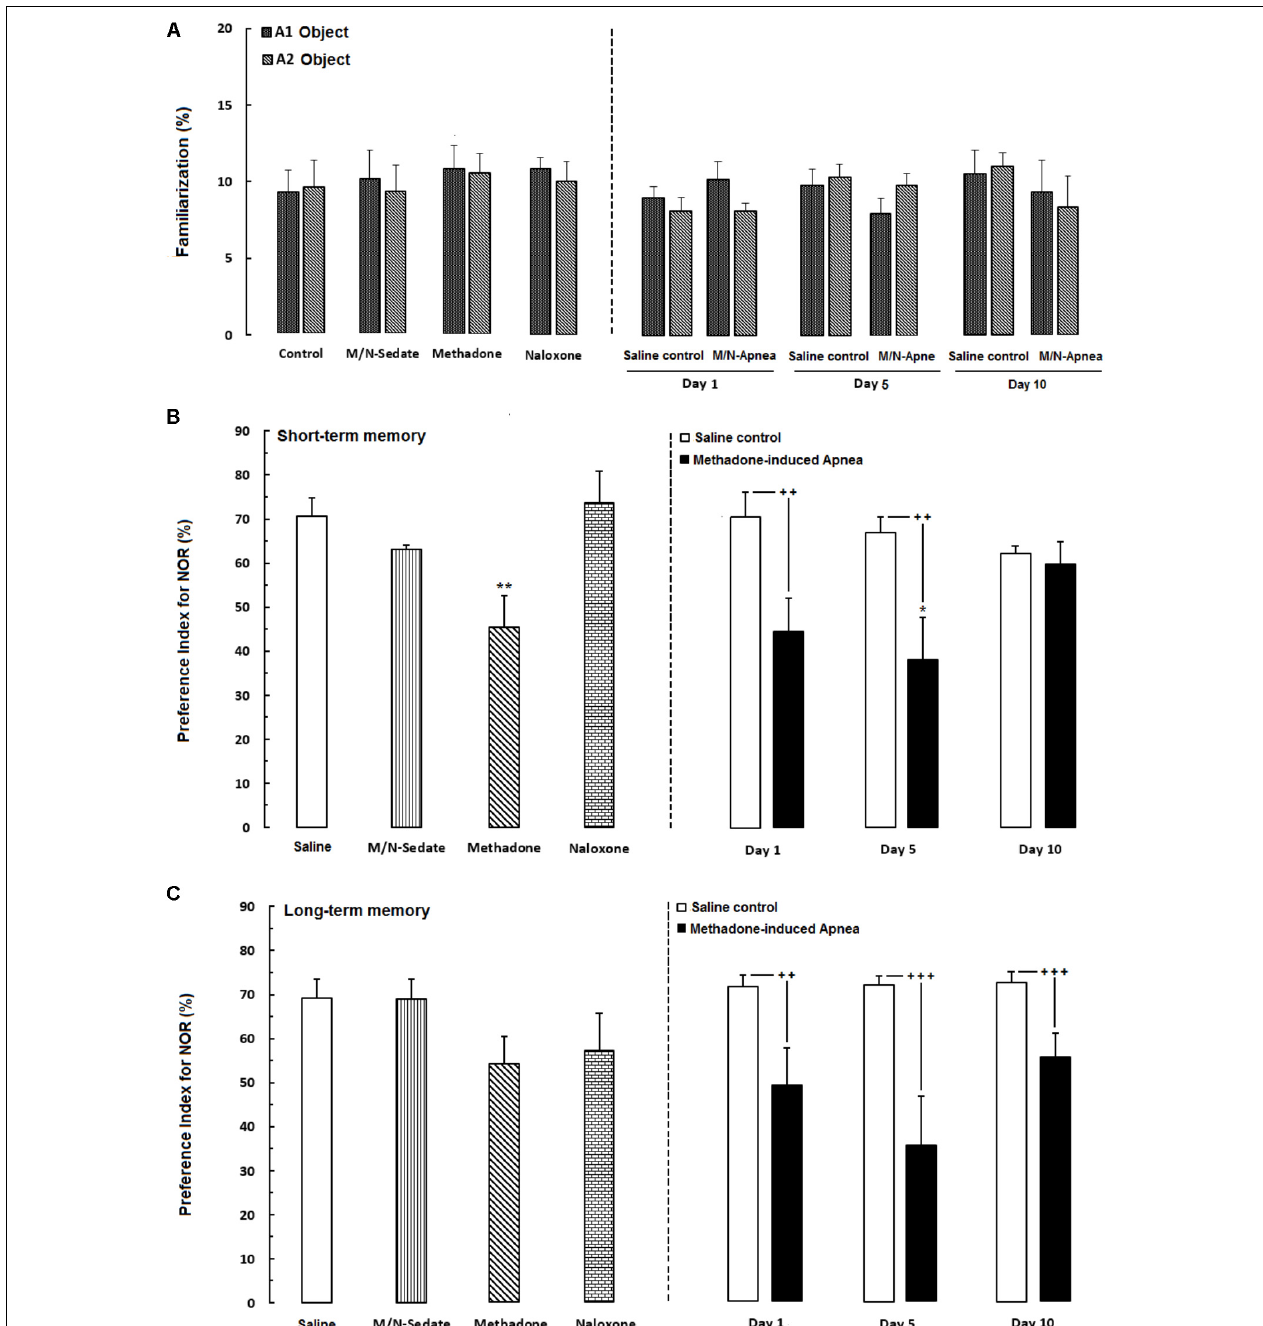
FIGURE 3 | Performance of recognition memory in the novel object recognition task in three sessions as follow; (A) Familiarization (rats were allowed to explore freely two identical objects A1 and A2 for 3-min), (B) Short-term memory (object A1 or A2 was replaced with object B while rats were allowed to explore for 3-min), (C) long-term memory (object B was replaced with object C which provided rats explored freely two objects for 3-min) in different groups, including; M/N-treated groups (a single dose of naloxone was administered after methadone overdose in apnea stage, in animals which experienced apnea and recognition memory was evaluated either on day 1, 5, or 10 day post-resuscitation; M/N-Day 1 ( n = 7), M/N-Day 5 ( n = 6) and M/N-Day 10 ( n = 6) groups and their respective Saline control groups ( n = 6); right panel), M/N-Sedate ( n = 7; a single dose of naloxone was administered following methadone overdose, immediately in the initial stage of sedation, so behavioral evaluation was carried out only 1 day after drug administration), Saline; n = 10, methadone; n = 11, naloxone; n = 8 (Saline, methadone or naloxone were administered alone in separated groups which recognition memory was evaluated only 1 day after the drug administration in adolescent rats) groups. Animals received methadone (15 mg/kg; i.p.) or naloxone (2 mg/kg; i.p.) alone or both in a single dose. Each bar shows the mean ± SEM for 6–11. ∗ P < 0.05 and ∗∗ P < 0.01 different from the Saline group. ++ P < 0.01 and +++ P < 0.001 different from their respective Saline control groups.